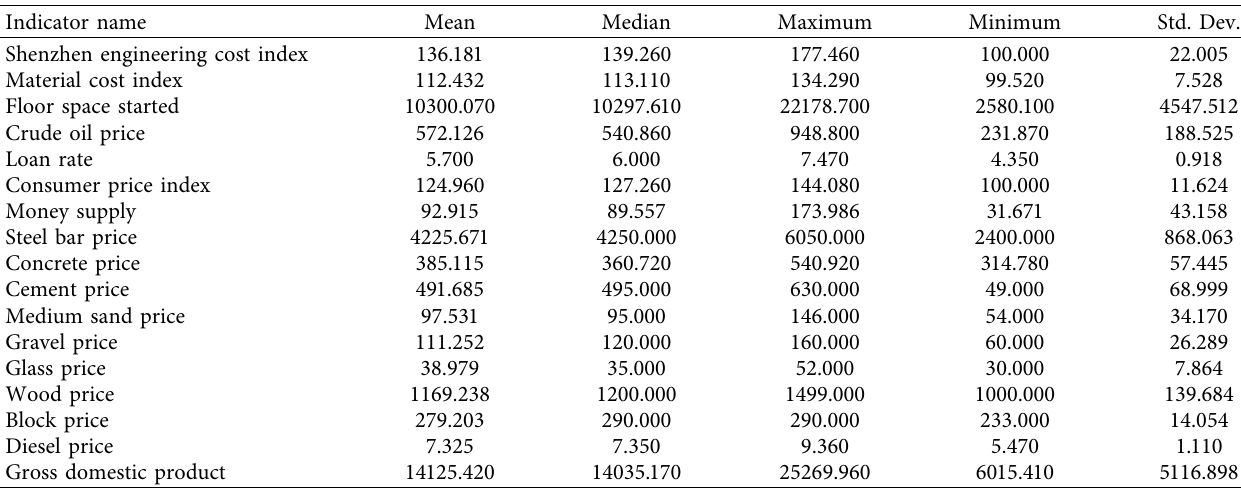
Table 2: Statistics of the primary selection index